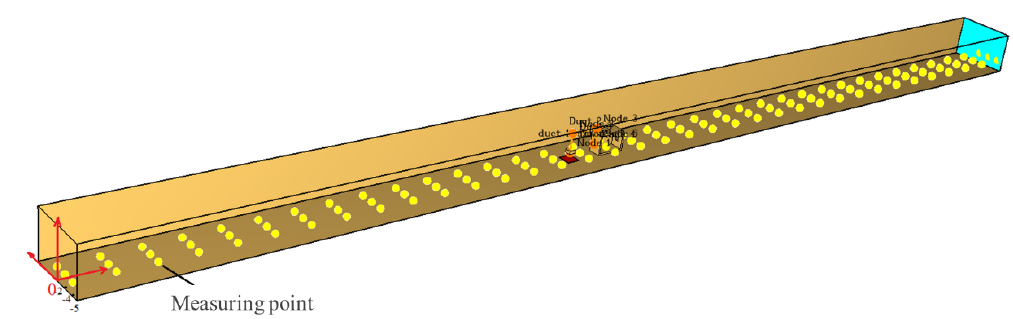
Figure 6. The arrangement of measuring points in the rectangular tunnel.